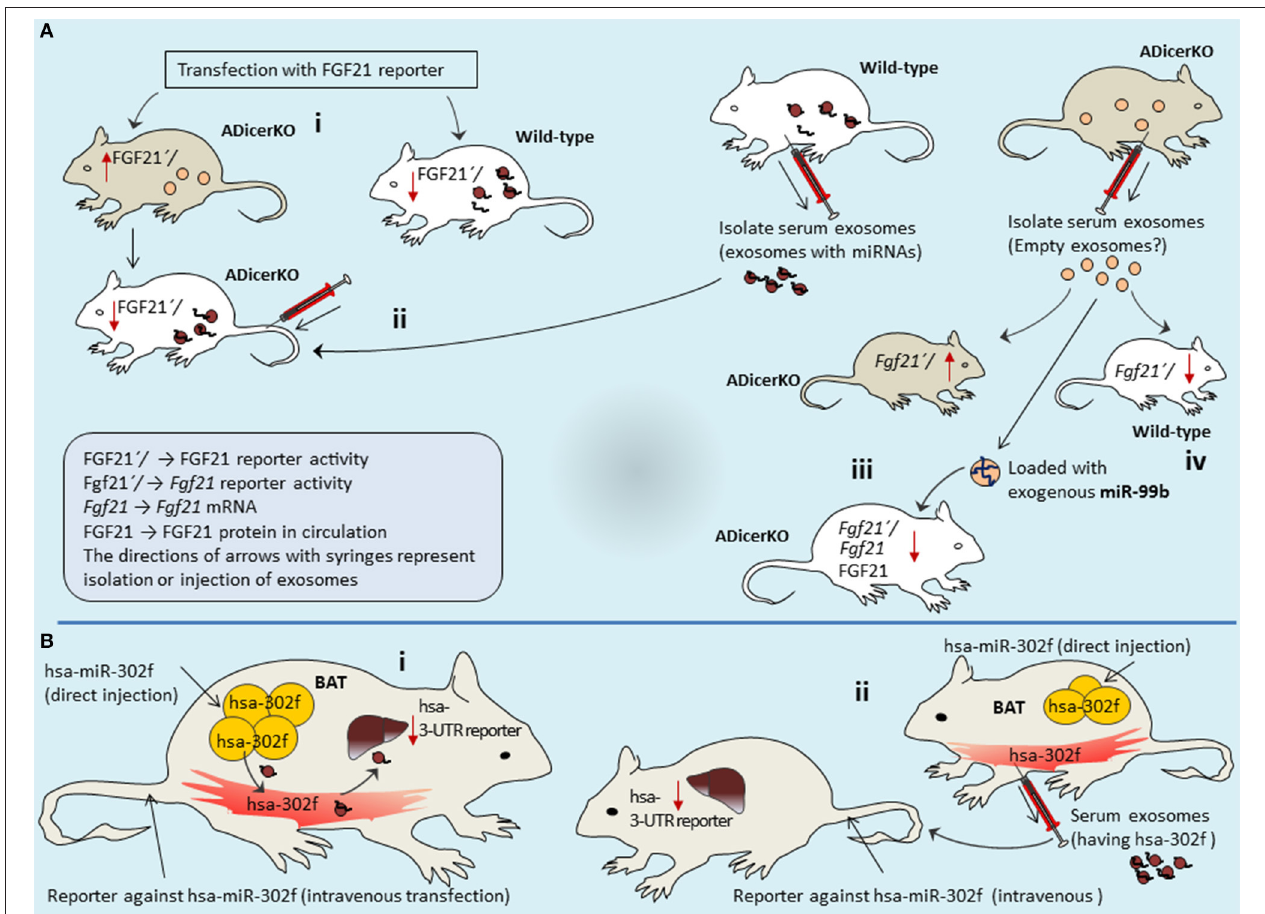
FIGURE 5 | Adipose-derived exosomes travel through circulation and regulate FGF21 expression in liver. ADicerKO and wild-type mice were transfected with FGF21 3 ′ UTR reporter via circulation (A-i) . Wild-type mice show reduced FGF21 reported activity due to presence of adipose-derived circulating miRNAs that is opposite for ADicerKO-mice which lacks adipose-derived miRNA. Upon injecting serum exosomes from wild-type to ADicerKO-mice the recipient ADicerKO-mice mimics the wild-type for reduced reporter activity (A-ii) . Since exosomes obtained from serum of ADicerKO lack miRNAs, they are loaded with foreign miRNA-99b and transferred back to ADicerKO which targets Fgf21 -mRNA and thus reduced expression of FGF21 (A-iii) ; this mimics the activity in in wild-type mice which already has miRNAs (A-iv) . (B) The expression of human hsa-miR-302f (which does not have mouse homolog) was directly induced in the BAT of mice (B-i) , and reporter of hsa-miR in the liver of same mice. BAT-expressed hsa-miR-302f obstructed the activity of reporter in the liver, indicating that adipose (BAT)-specific miRNAs follow the route to liver. (B-ii) human hsa-miR-302f expression was induced in the BAT of one mice and reporter in the liver of other mice, and hsa-miR-302f containing exosomes from BAT were injected intravenously to mice having reporter. This results into reduction of reporter activity in the liver of recipient mice. BAT, Brown adipose tissue; ADicerKO, Adipose specific